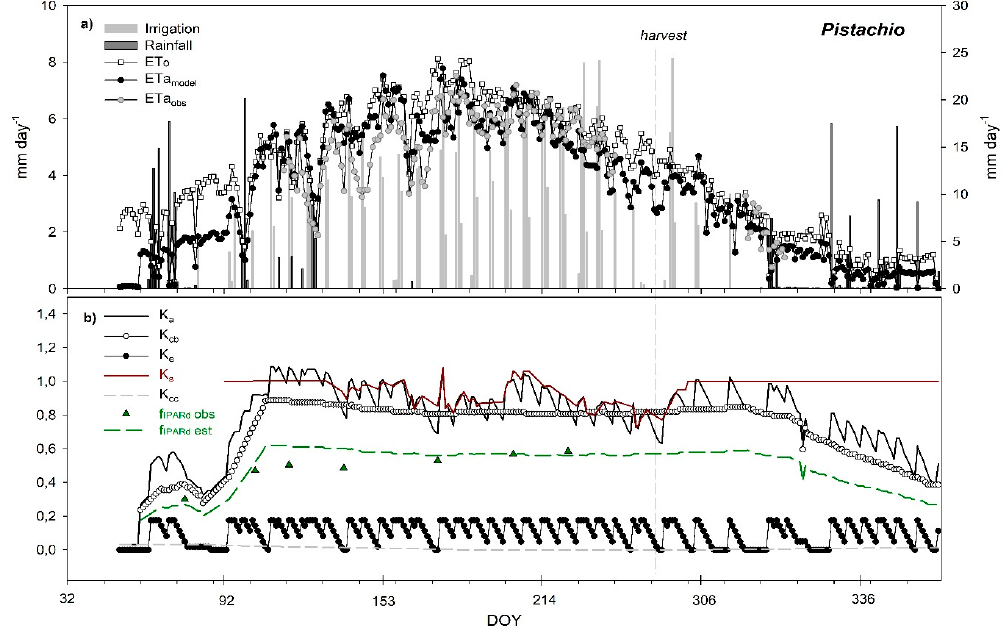
Figure 10. Seasonal trend of the different parameters contributing to evapotranspiration of the pistachio orchard: ( a ) ETa model and ETa obs (flux tower) throughout the growing season along with ETo, rainfall and irrigation; ( b ) modeled actual crop coefficient (K a ), basal crop coefficient (K cb ), soil water evaporation coefficient (K e ), water stress coefficient (K s ), cover crop coefficient (K cc ), and the observed (f IPAR d obs) and estimated (f IPAR d est) daily fraction of intercepted radiation. After each irrigation event in the almond orchard, the actual crop coefficient ( K a ) peaked to maximum values of 1.3 at full-development, which progressively decreased to minimum values